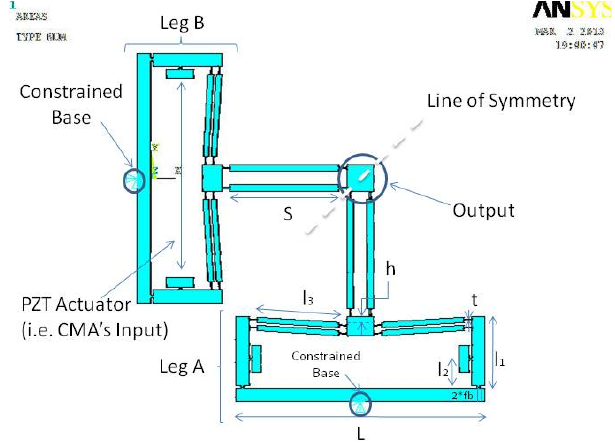
Fig. 2. Planar motion generator CMDA based on symmetric five-bar topology Figure 2. Planar motion generator CMDA based on symmetric five- bar topology. Table 1 below also lists the initial values of the most important parameters used to design the planar motion generator CMDA. Please note that the minimum dimensions that parameters l 2 and L can adopt are related to the dimensions of NPA50SG actuators that will be integrated within each leg. S is determined to make two directional motions possible in a compact size. Parameter h also stipulates the inclined angle of the double parallel bars, referring to Fig. 1(b). Finally parameters t and fb represent the thickness of the rectangular and circular flexure hinges, respectively. The thickness of the CMDA is 10 mm.